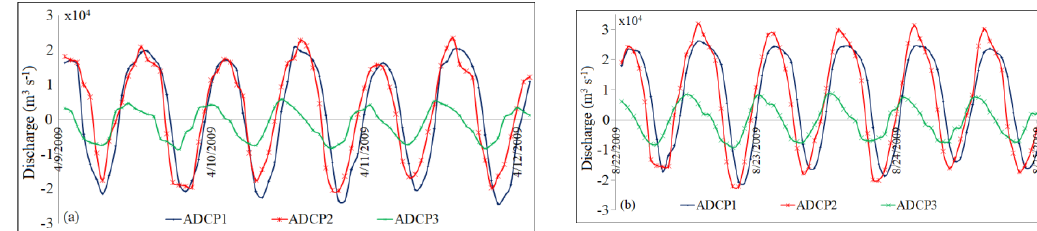
Figure 4. Variation of 74 h water discharge measured at ADCP1, ADCP2, and ADCP3 stations during the dry season (9–12 April 2009) ( a ) and the flood season (22–25 August 2009) ( b ).